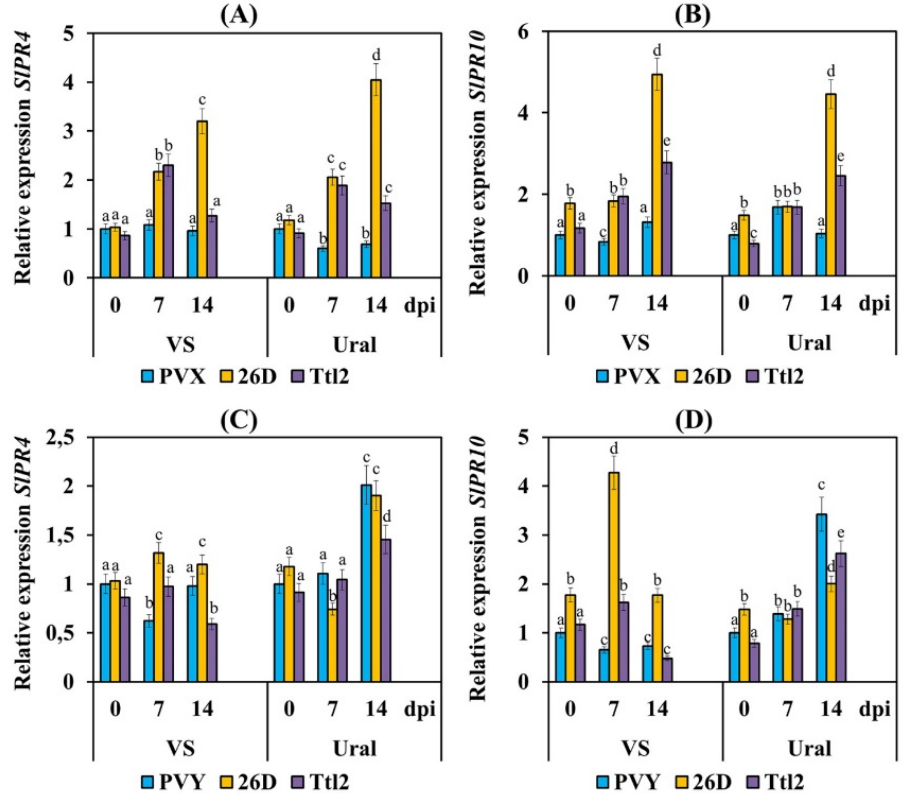
Figure 5. Influence of endophytic strains B. subtilis 26D and B. subtilis Ttl2 on the relative expression of the genes SlPR4 ( A , C ) and SlPR10 ( B , D ) in tomato plants of the varieties Volovye Serdtse (VS) and Ural infected with PVX ( A , B ) and PVY ( C , D ). The expression values were normalized to the housekeeping gene of tomato plants, SlACT, as an internal reference. The samples are indicated as follows: 0 dpi, control non-infected plants; PVX, plants infected with potato virus X; PVY, plants infected with potato virus Y; 26D, plants treated with B. subtilis 26D; Ttl2, plants treated with B. subtilis Ttl2. The figures present means ± SE (n = 6). The treatments marked with different Latin letters in one cultivar are statistically different from the control ones (0 dpi, not infected with viruses and not treated with bacteria) in each time-point, according to the LSD test ( p ≤ 0.05). Infection with PVX and PVY of plants of both varieties, which were treated with 26D and Ttl2, increased the transcript levels of the PR4 and PR10 genes in all treatments except Ttl2 + PVY in the VS plants (Figure 5). At the same time, the Ttl2 strain had a weaker effect